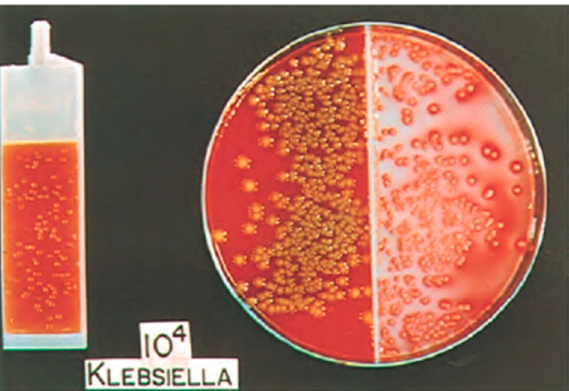
Figure 1. Split-Agar Urine Culture—blood agar ( left ) and eosin-methylene blue (EMB) ( right ). Adapted from Campbell-Walsh Urology 11th edition [7].